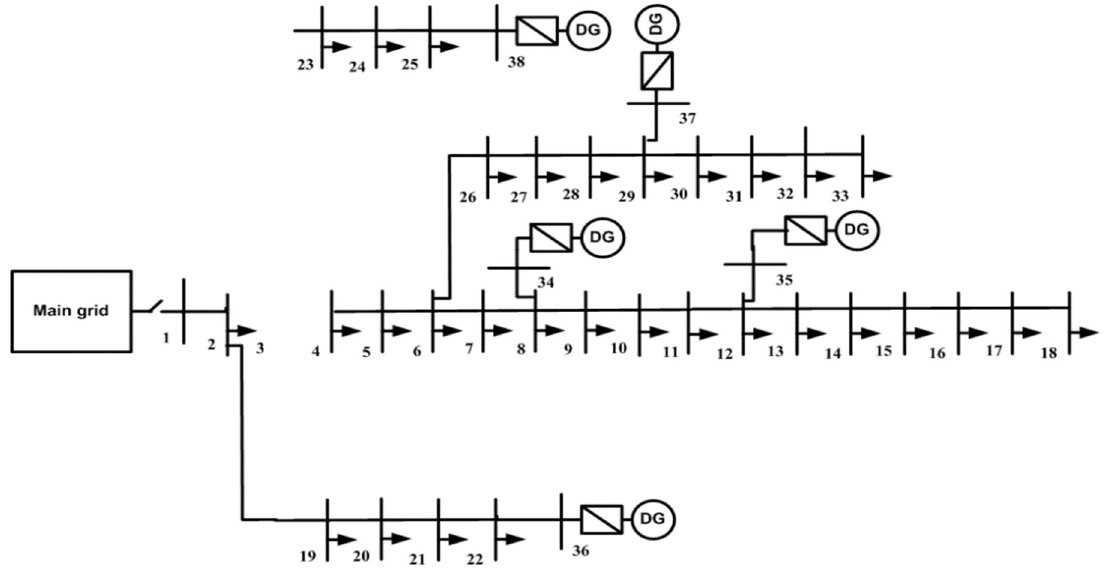
Figure 4. Three subsystems due to the removed faulted bus #3.